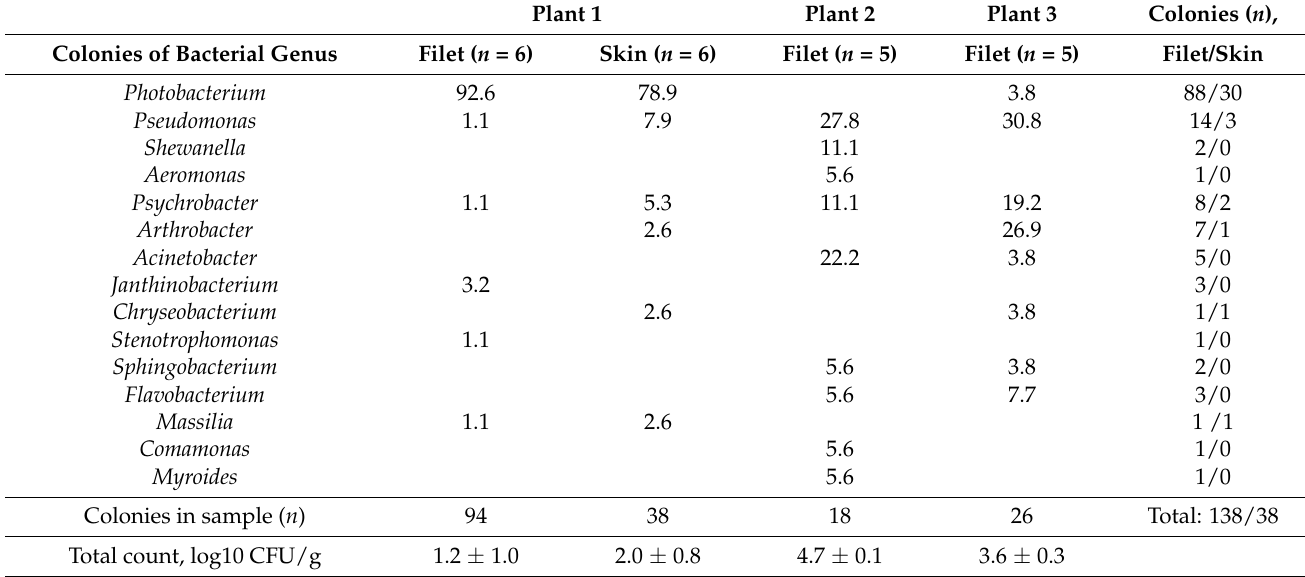
Table 1. Bacteria (%) identified (by 16S rRNA gene sequencing of colonies) from three different processing plants, one day after slaughtering and filleting. At Plant 1 samples were taken from both the skin and from the flesh (fillet). Plant 2 and 3 were industrial processing plants with sampling of the